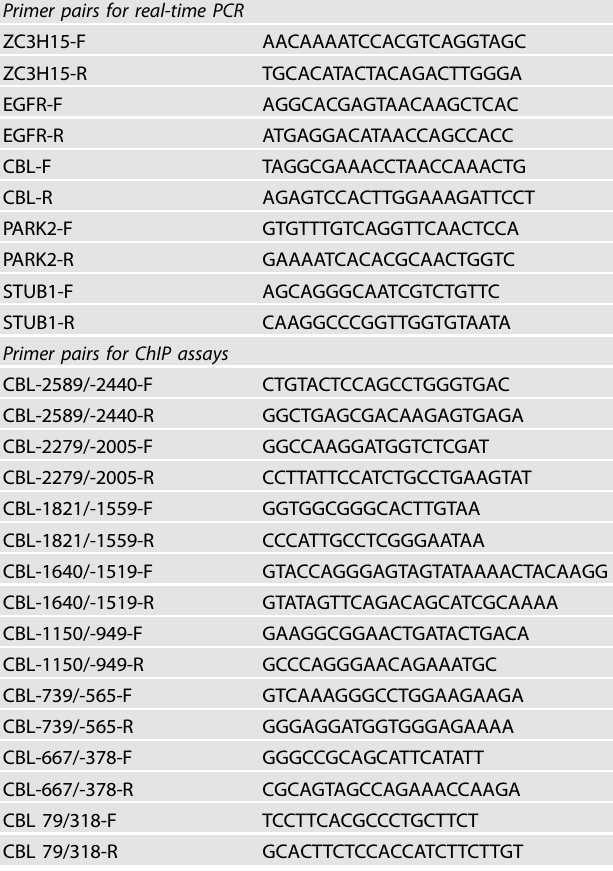
Table 1. Primer pairs for real-time PCR and ChIP